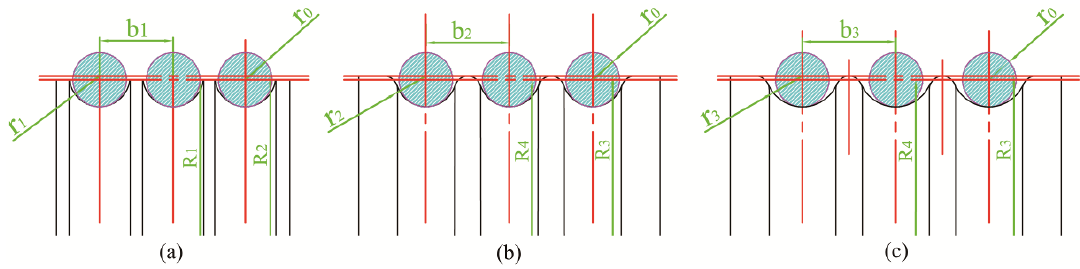
Figure 1. Groove shapes. ( a ) Typical groove shape for cast parts; ( b ) ideal groove shape for spinning sheaves; ( c ) general groove shape.